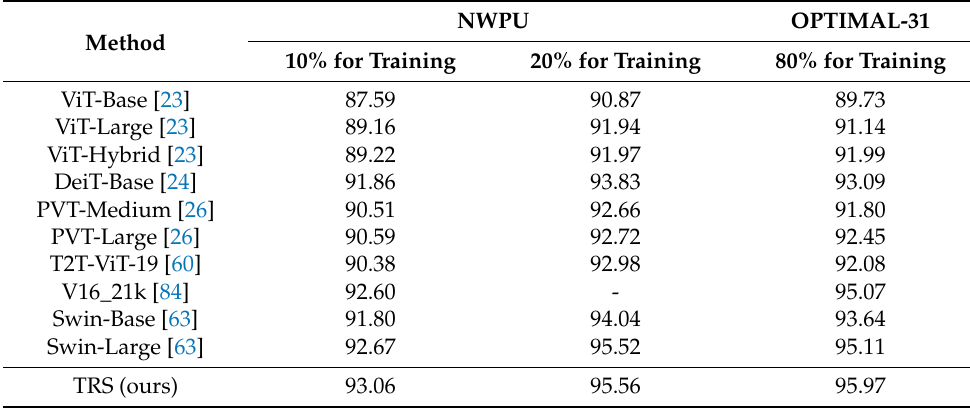
Table 9. Comparison with other Transformers on NWPU and